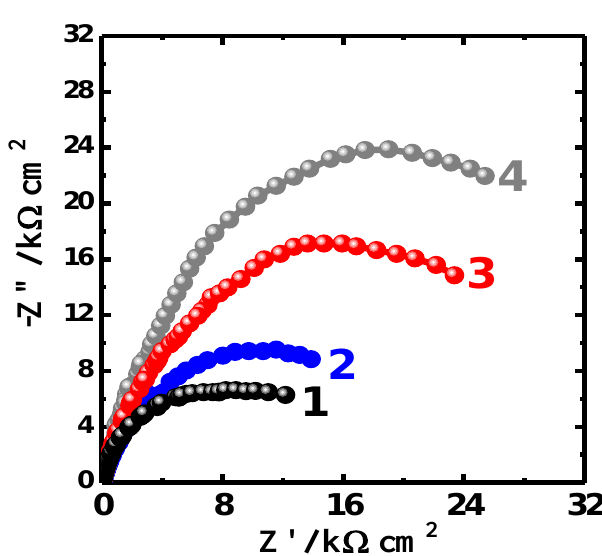
Figure 3. Nyquist spectra collected for 6061 alloys, ( 1 ) the as received and the extruded alloys at ( 2 ) 350, ( 3 ) 425, and ( 4 ) 500 °C, respectively after the immersion for 1 h in 3.5% NaCl solutions.